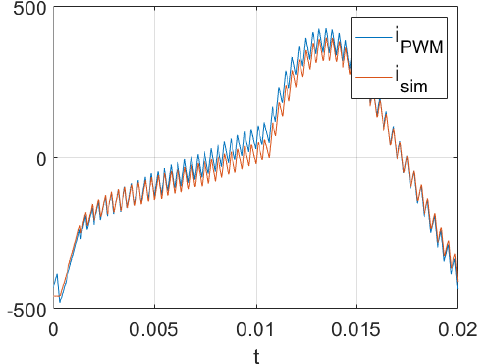
Figure 9 . A comparison between the calculated PWM current i PWM and the simulated current i sim [A]. To confirm the correctness of the PWM current calculations, a simulation was carried out in Matlab/Simulink using the real Full-Bridge Converter model.